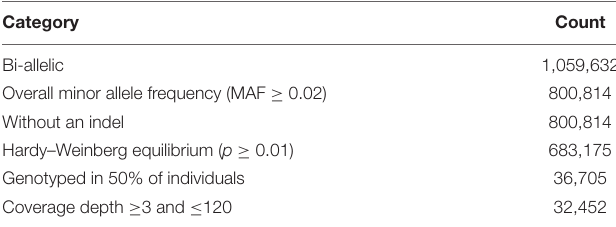
TABLE 2 | Number of filtering SNP candidates retained after each step of filtering.